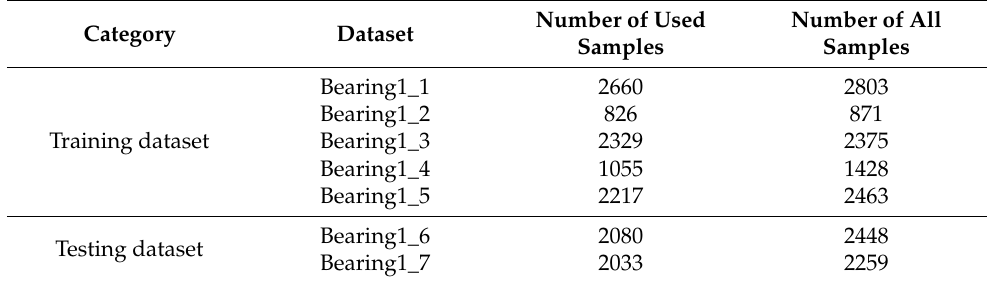
Table 3. Dataset division and